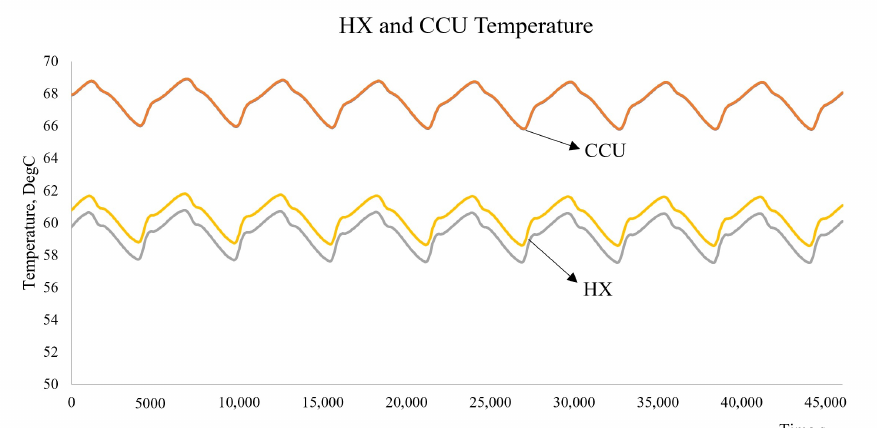
Figure 20. 6U Satellite deployable radiator with Thermal Straps—CC and HX Temperature.